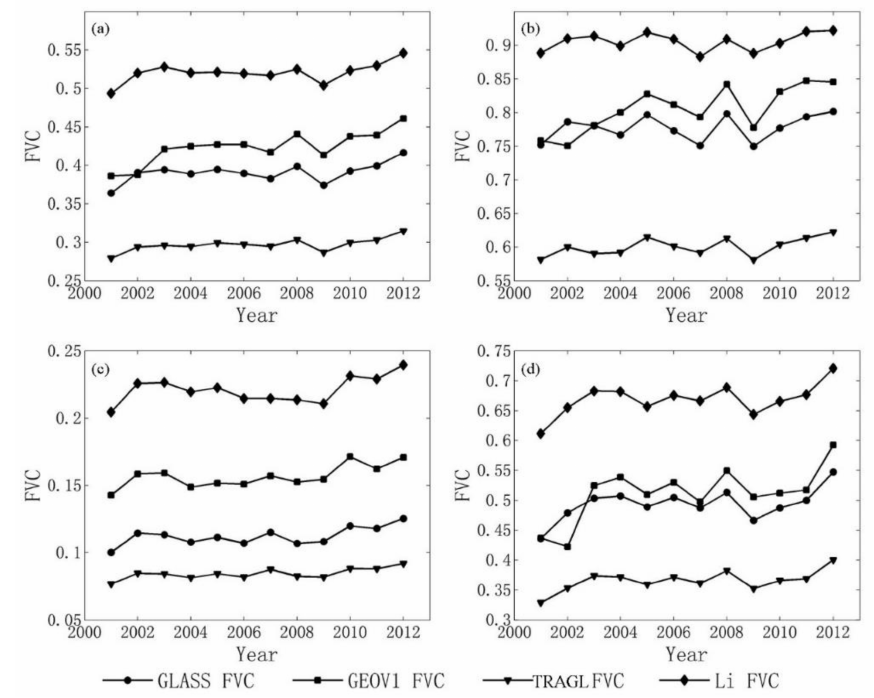
Figure 4. The averages of annual mean maximum FVC of four data sets over the period 2001–2012. ( a ) northern China; ( b ) Northeast China; ( c ) Northwest China; ( d ) North